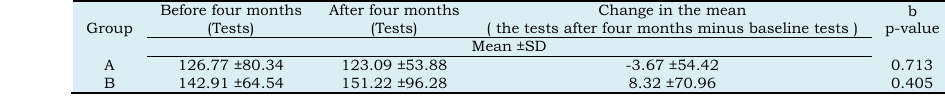
Table 4 Comparison of TG (mg/dl) concentrations before and after four months.